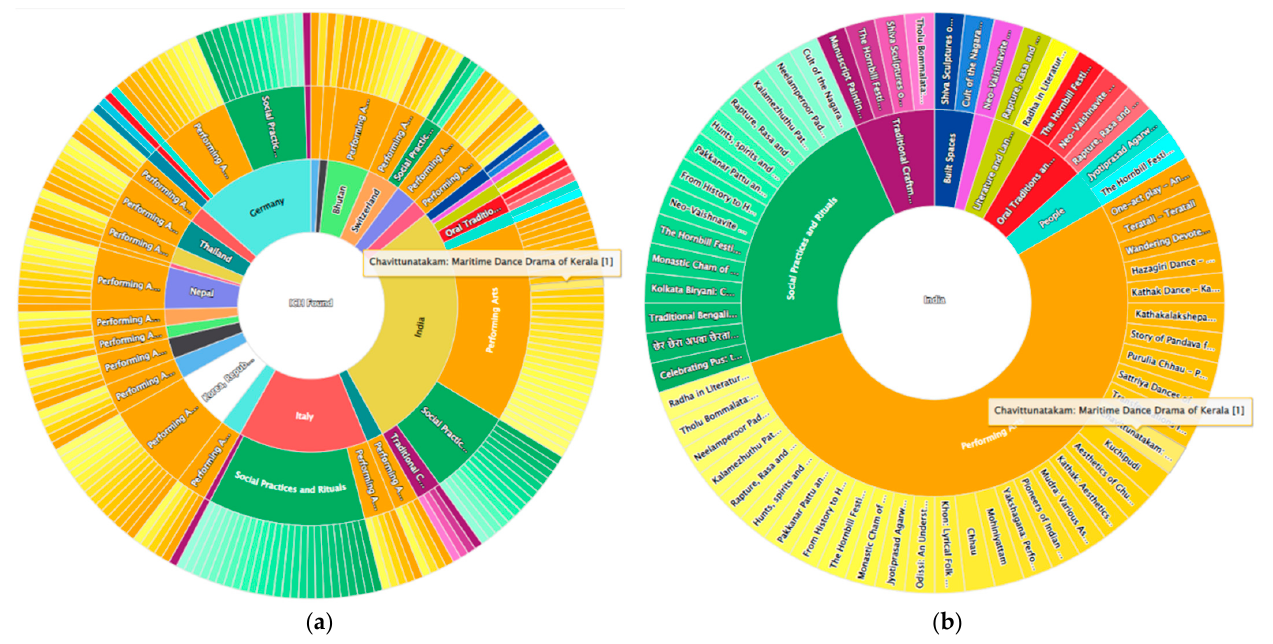
Figure 12. Results for theme “Traditional dances” by sunburst: ( a ) main key for the inner circle is the country; ( b ) selection of key “India” from the inner circle.